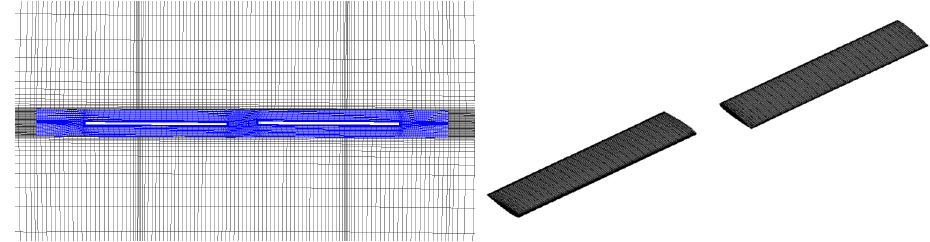
Figure 2. Spatial sectional and surface grid on Caradonna–Tung rotor.